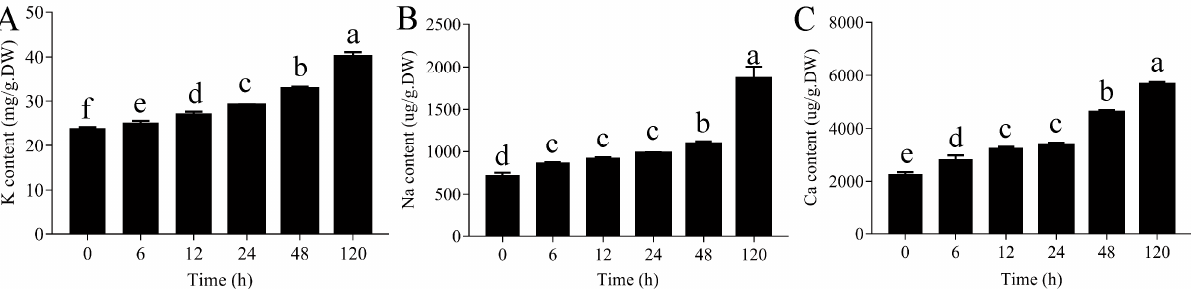
Figure 8. Measurement of mineral content. ( A ) K content, ( B ) Na content, and ( C ) Ca content. Different lowercase letters indicate statistically significant differences at p < 0.05. The values are shown as the mean of three biological replicates ± SE ( n = 3).